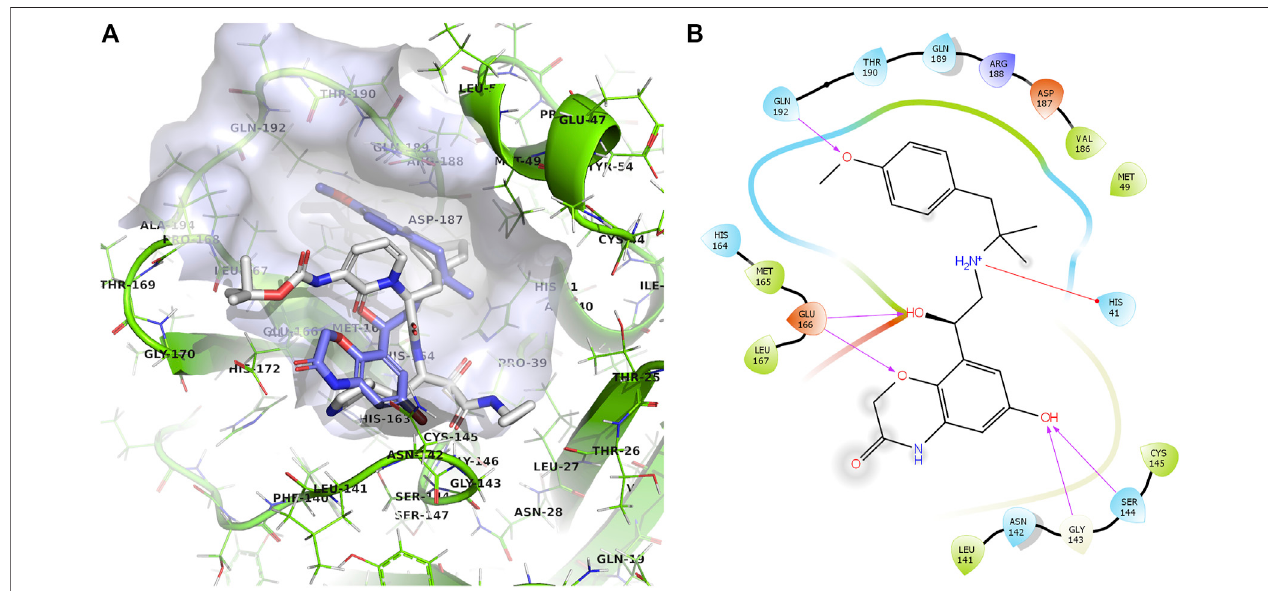
FIGURE5|(A) :Prepared3CL pro dockingtarget inthegreencartoonmodelwithlabeledactive siteresidueswithcalculateddockingposeofolodaterol(12)shown in the light-blue stick model superposed on the OEW reference ligand in the white stick model. The binding site surface around the ligand is emphasized in transparent blue-gray color. (B) : 2D projection of the calculated docking pose of olodaterol (12) indicating key residues in vicinity and ligand-binding site interactions.